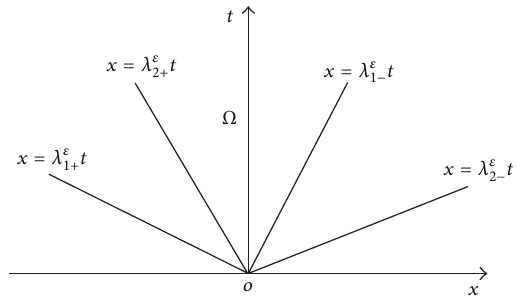
Figure 1: Wave curves in the phase plane. Figure 2: Characteristic lines for constant states ( V